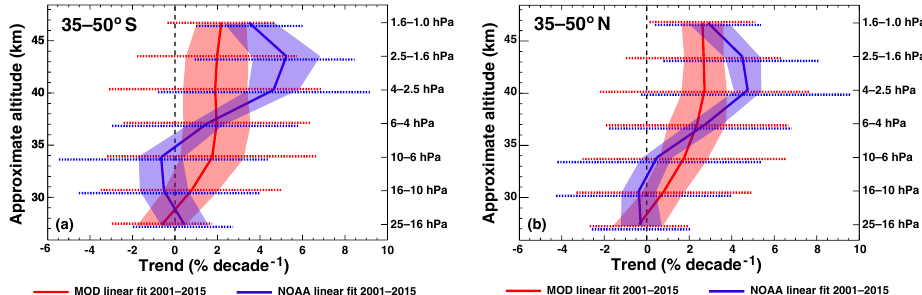
Figure 11. Linear trends fit from 2001 to 2015 using MOD (red) and NOAA Cohesive (blue) merged ozone records. Trends are in percent per decade and plotted as a function of pressure layers at 35–50 ◦ S (a) and 35–50 ◦ N (b) .